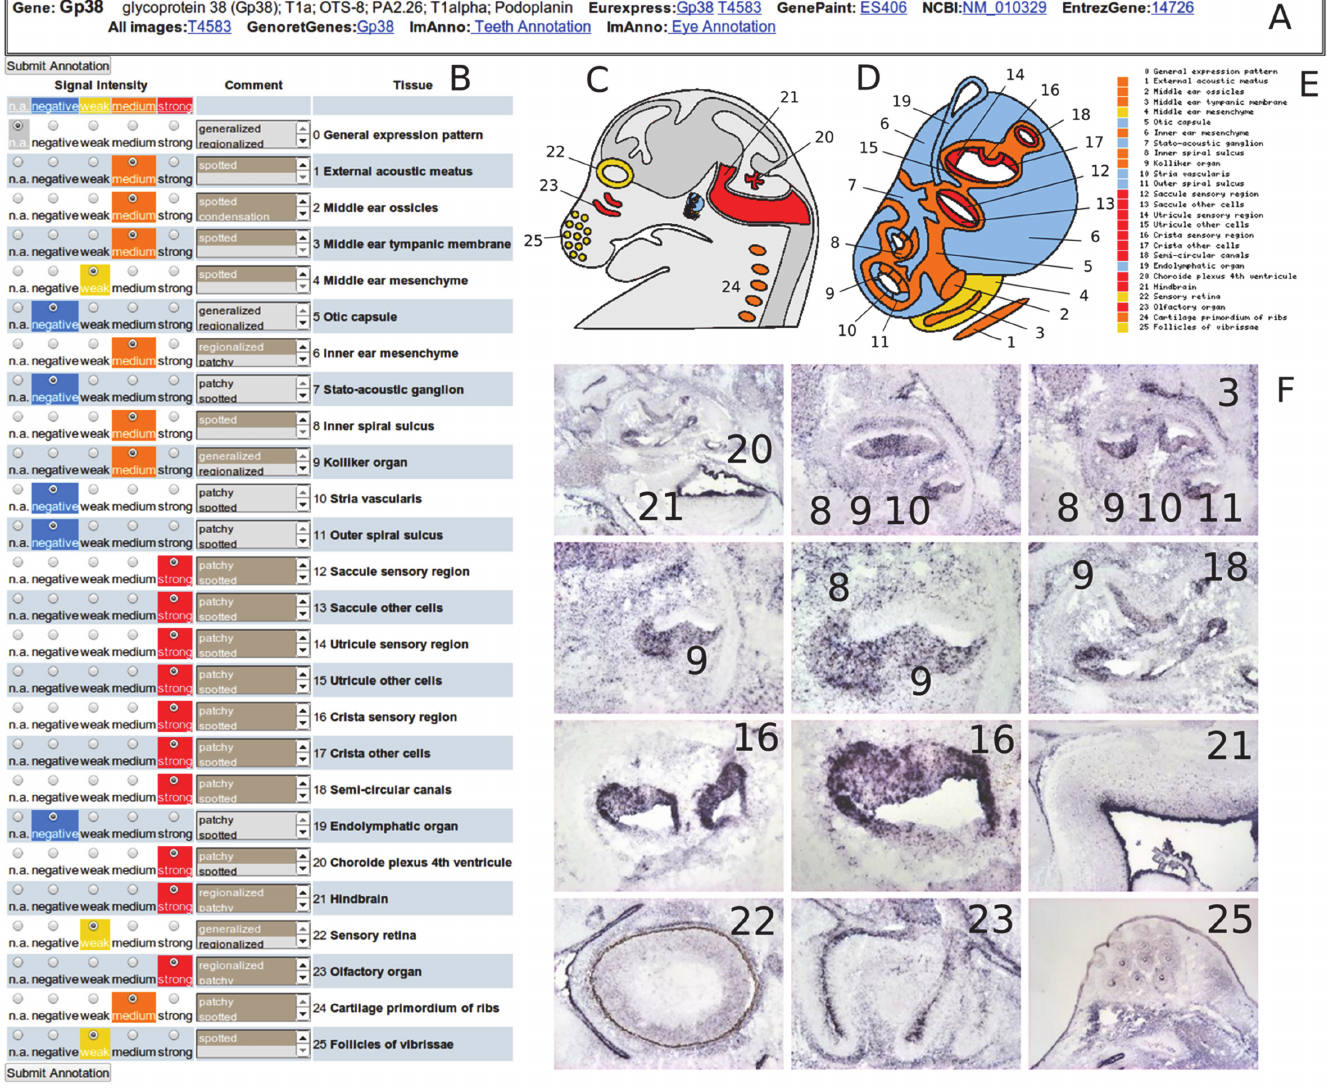
Fig 1. ImAnno web page of the Gp38 gene. A: Upper header provides information about the gene and links to other databases. B: Annotation form with radio buttons to select expression values (n.a.: not analyzed), negative, weak, medium, strong are associated with a blue, yellow, orange, red color code respectively. Predefined keywords or free observations can be added in the Comment boxes. C-E: User accessible web form summarizing the expression features (with the same color codes) in a tissue schema (C, D) with the numbered tissue list (E). F: Overview of the ISH images used to annotate the Gp38 expression pattern with the respective tissue